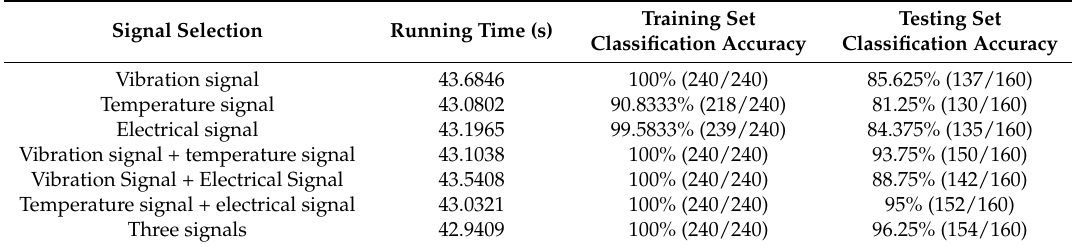
Table 5. Diagnostic results of different